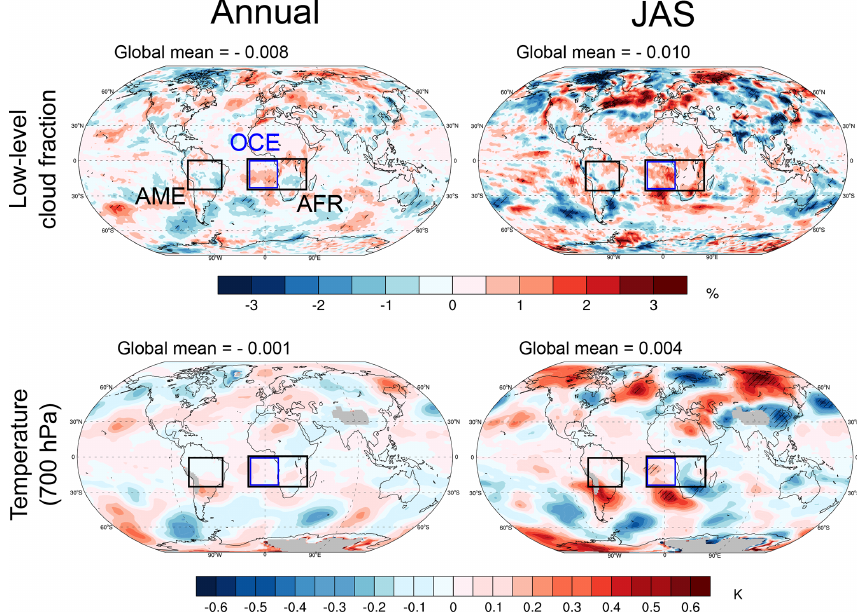
Figure 13. Changes between the BRC and NOBRC simulations (BRC minus NOBRC) in low-level (below 640hPa) cloud fraction (%, relative percentage difference of cloud fraction) and temperature (K, 700hPa) averaged over the year and over JAS. Hatching indicates regions with a significant effect at the 0.05 level (Wilks test).